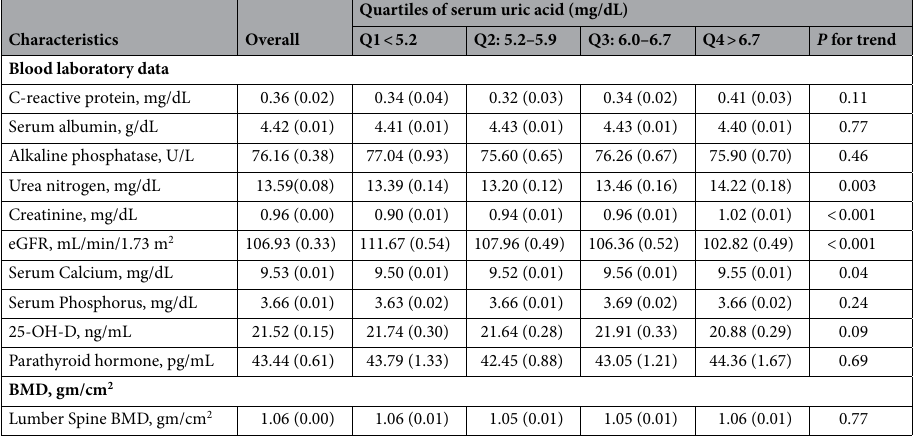
Table 2. Serum biochemistry and lumbar spine bone mineral density based on SUA quartiles, weighted. Data are expressed as weighted means (standard error, Se) or proportions (Se). BMD Bone Mineral Density, eGFR estimated glomerular fltration